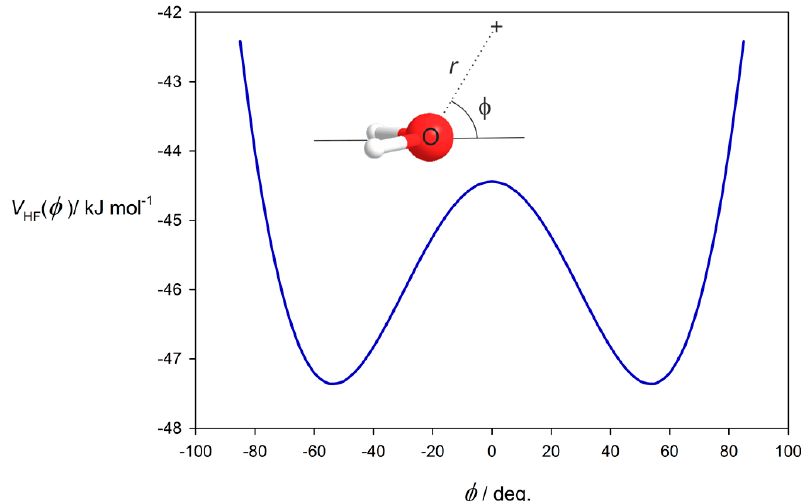
Figure 2. Variation of the electrostatic potential energy V HF ( φ ) of HF as a function of the angle φ made by the vector r with the C 2 axis of the H 2 O molecule. HF is treated as an extended electric dipole (see text for details). r is the distance of the H atom of HF from the O atom in H 2 O. The O ⋯ H–F nuclei are assumed collinear in the model.